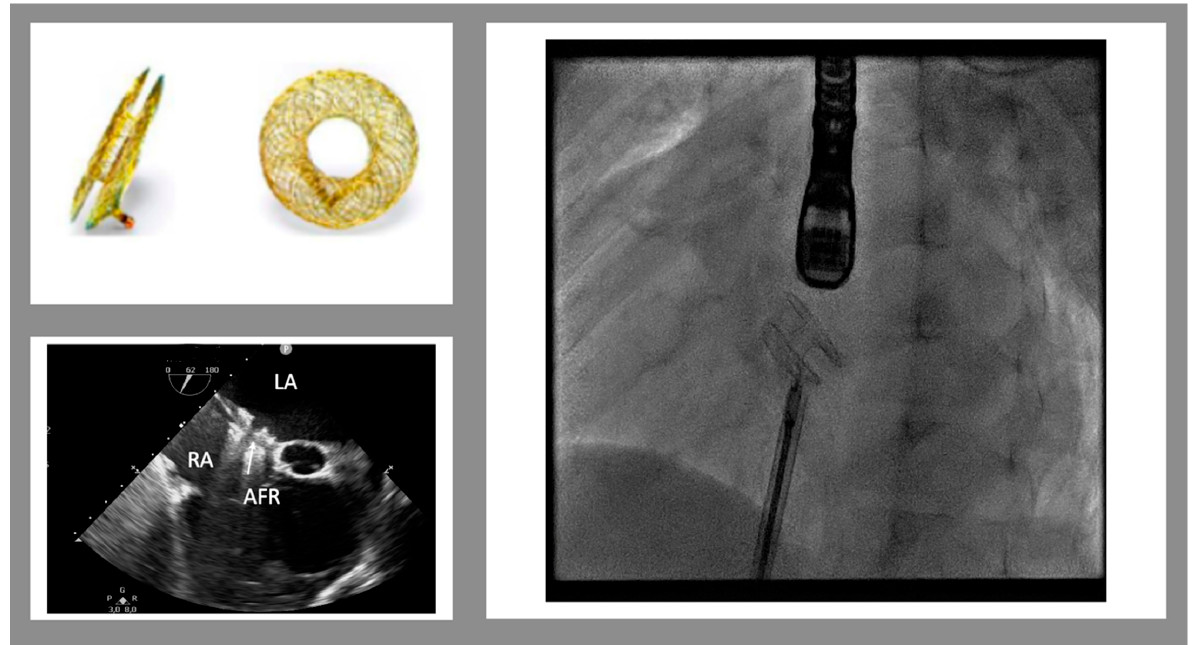
Figure 1. Atrial flow regulator device. Top on the left: the device in frontal and lateral views. The bottom on the left shows the trans-esophageal view of the implanted device (mid-esophageal view, 52°). On the right is a fluoroscopic view of the device just before the release. (LA left atrium, RA right atrium, AFR atrial flow regulator)